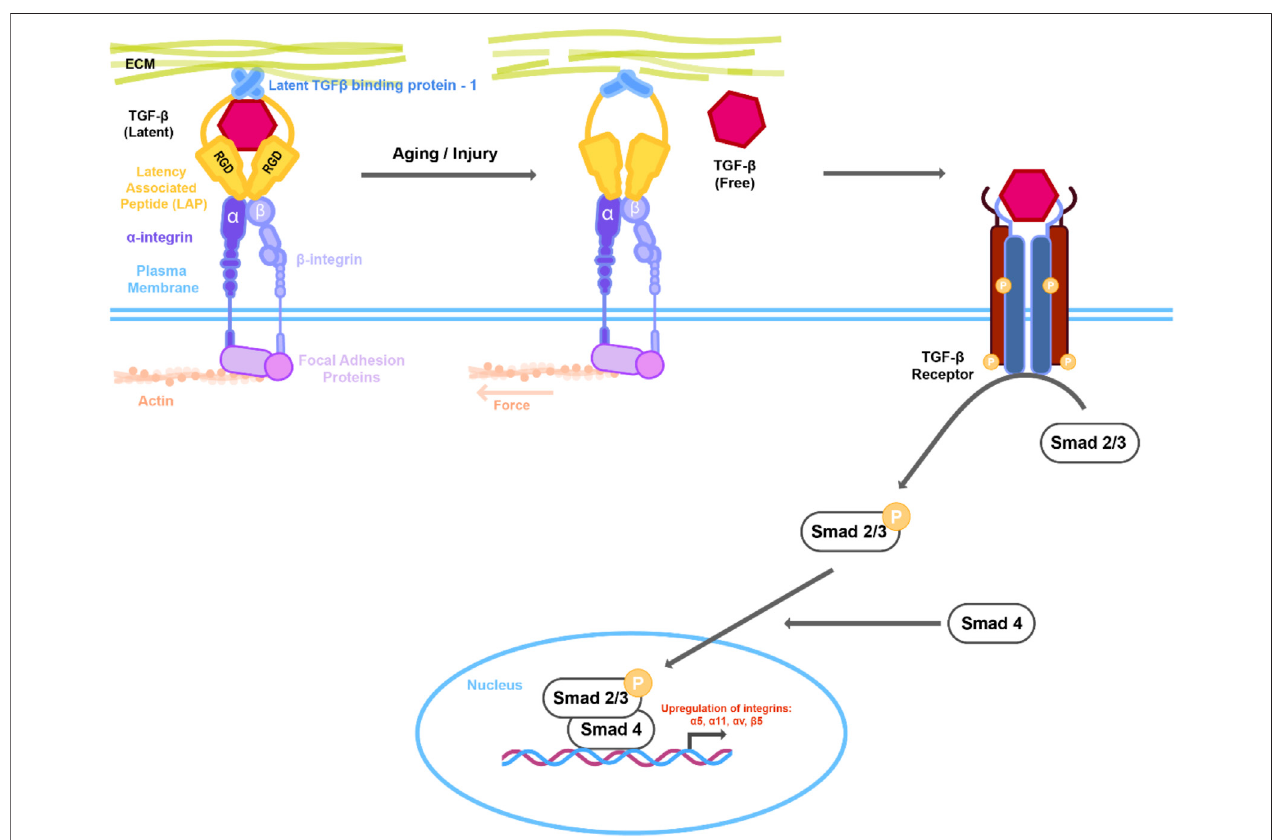
FIGURE 1 | Mechanical changes in actin cytoskeleton or extracellular matrix (ECM) lead to activation of TGF β signaling. Latent TGF β is stored in the ECM together with the latent TGF- β 1 binding protein (LTBP-1) and the latent associated peptide (LAP) that in turn is complexed with integrins. Changes in the actin/myosin mediated cellcontractionorECMarchitectureduetoagingorinjuryresultsinputativeconformationalchangeintheLTBP-1/LAPcomplexleadingtoreleaseofTGF β .Interactionof active TGF β with its receptor activates downstream Smad signaling. Active Smad2/3 in complex with Smad4 then translocates to the nucleus resulting in upregulation of downstream genes including